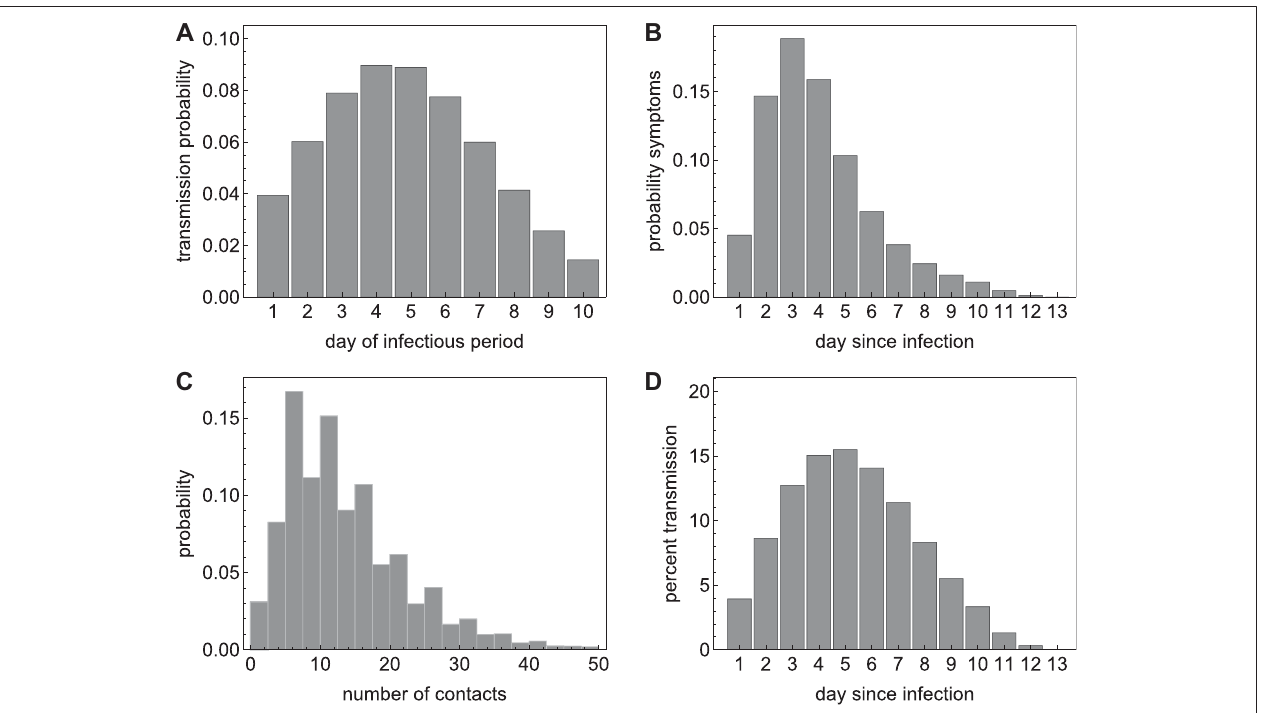
FIGURE2 | (A) The transmission probability per day of the infectious period; (B) the probability ofdevelopingsymptoms per day since infection; (C) the probability distribution of the number of contacts per day; and (D) percent onward transmission per day since